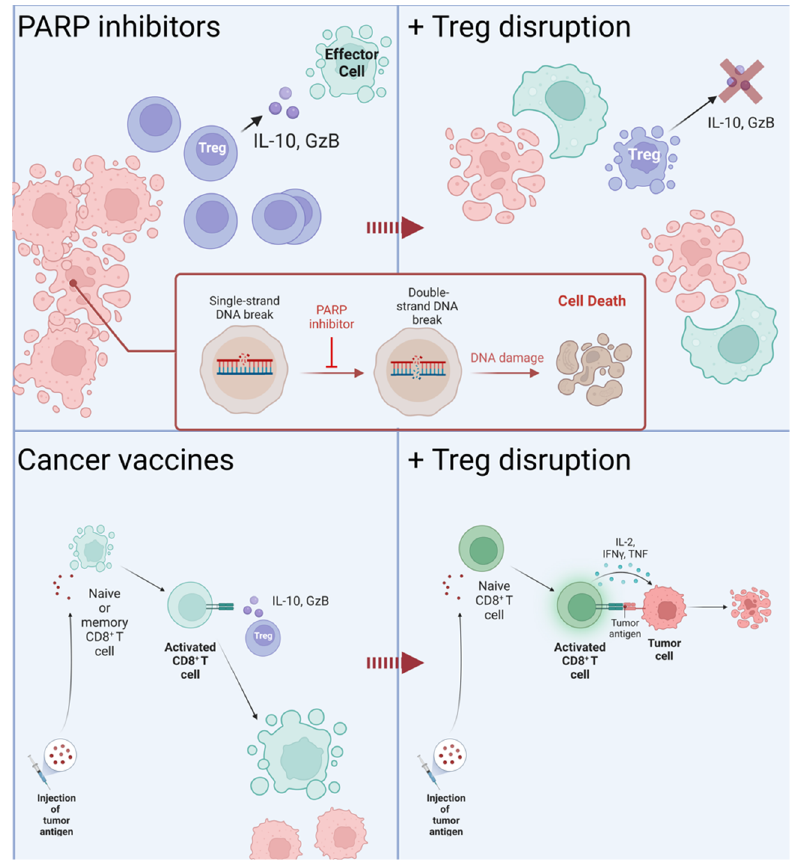
Figure 5. Outcomes of cancer therapy in combination with Treg-targeting treatments. Treatment with PARP inhibitors targets DNA repair mechanisms, causing lethal damage to cancer cells. Apop- tosis of cancer cells attracts immune cells to clear cell debris, at which point it may become sensitized to cancer antigens [92]. The presence of Tregs in the tumor microenvironment suppresses the re- sponse to cancer antigens; inhibition of their function allows the immune system to begin to respond to cancerous cells. Cancer vaccines increase the immune response to cancer antigens by sensitizing effector cells away from the tumor [93,94]. Without the depletion of Tregs, the benefit of these cells is lost as they are suppressed once they reach the tumor.